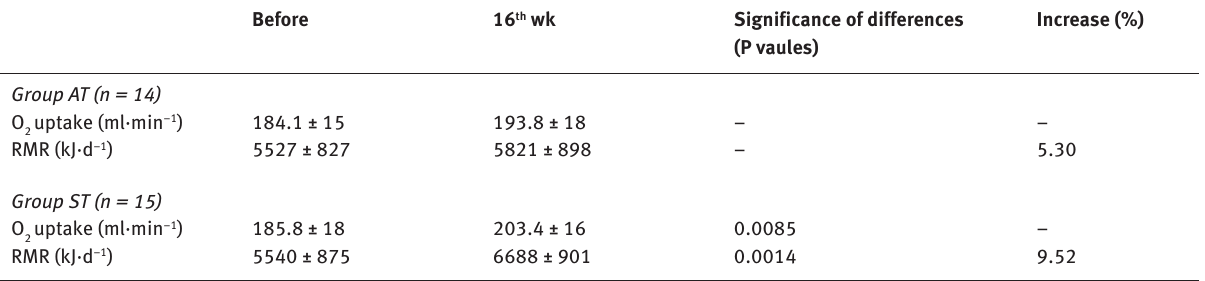
Table 4: Resting oxygen uptake and rest metabolic rate changes related to 16 wks of aerobic (АT group) and strength (ST group) training of overweight females (mean ±